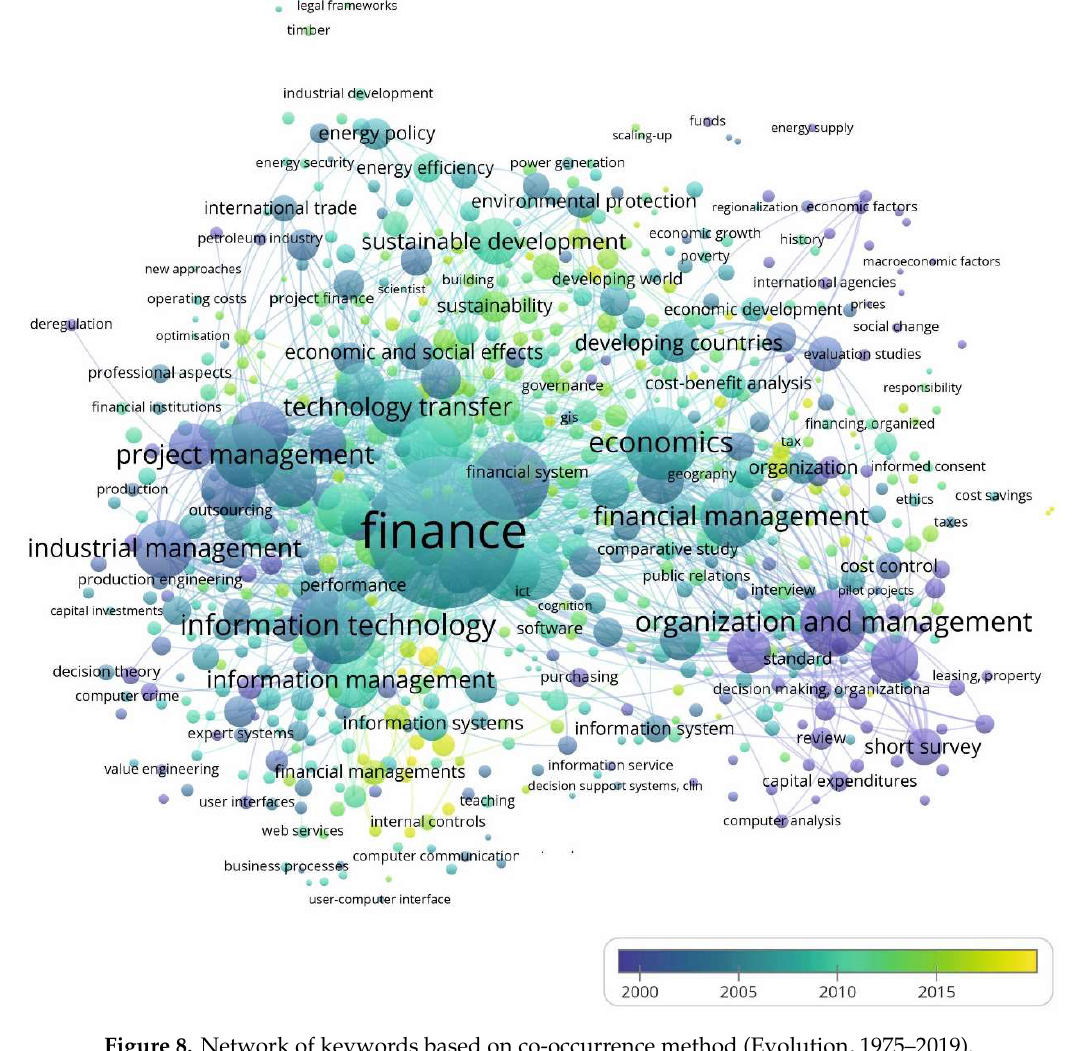
Figure 8. Network of keywords based on co-occurrence method (Evolution, 1975–2019).